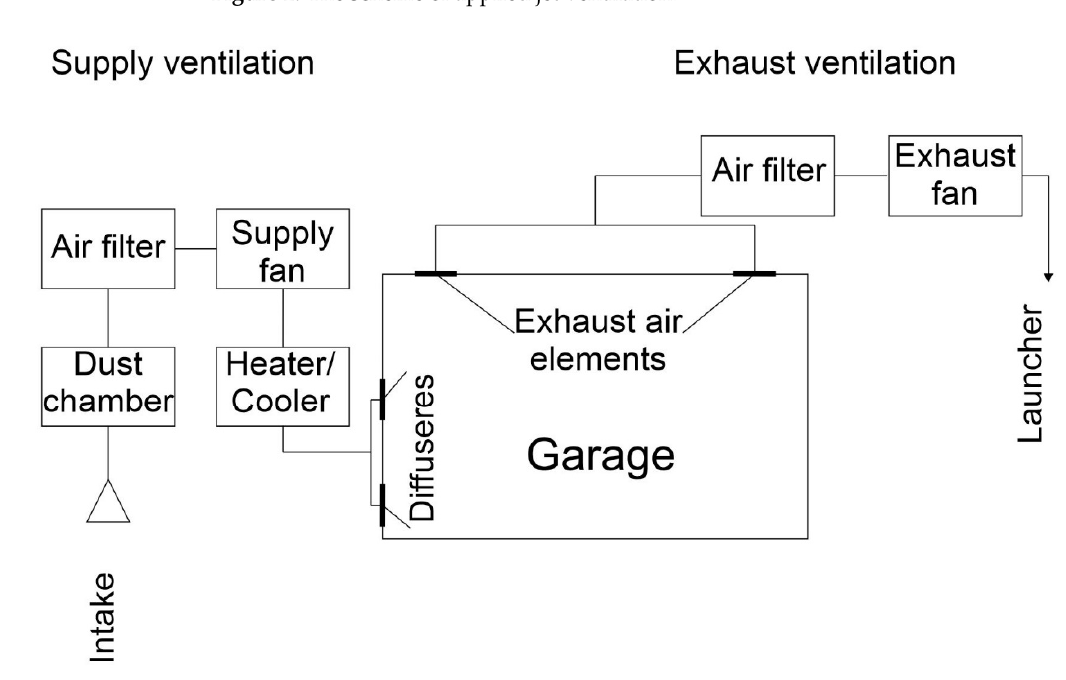
Figure 3. The scheme of applied duct ventilation.